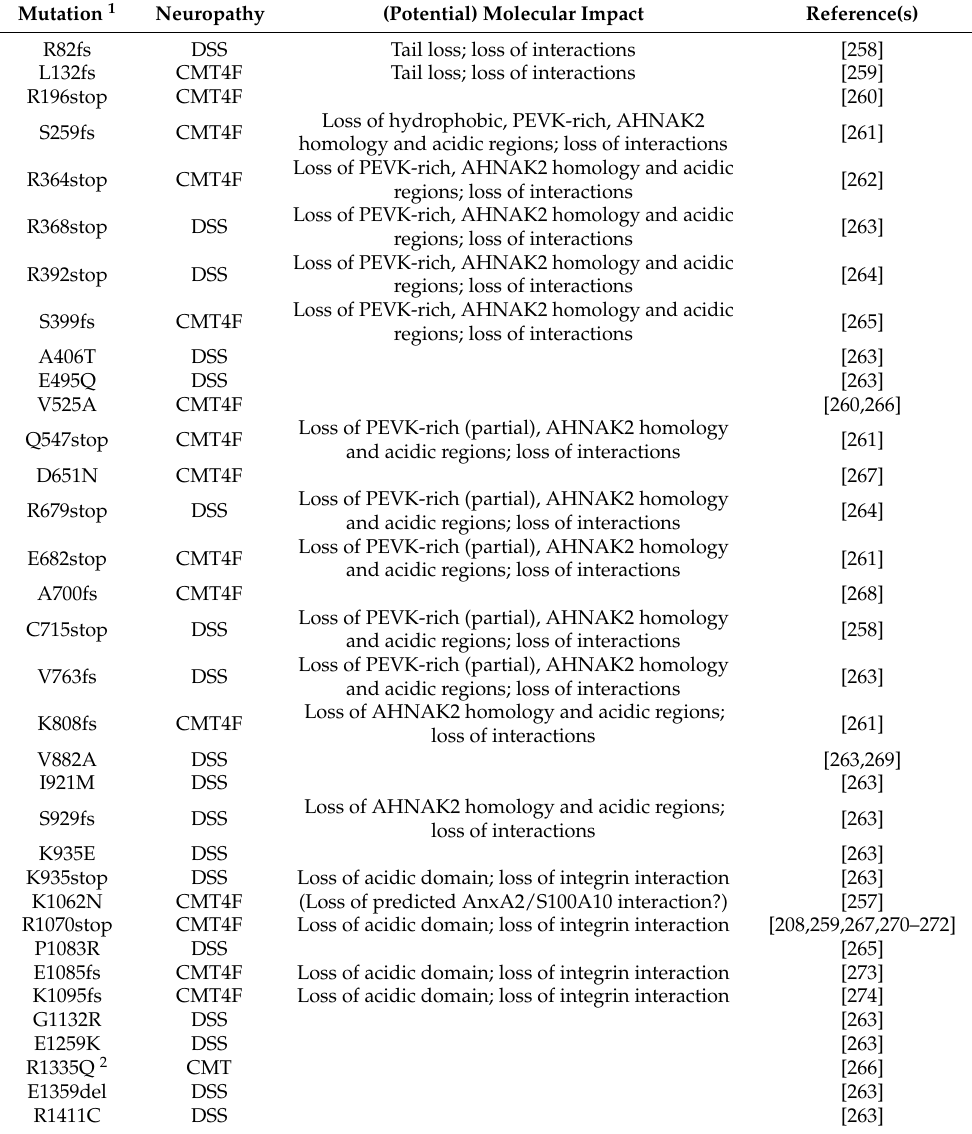
Table 1 has been modified. The updated table is shown below. Table 1. PRX mutations, related neuropathies and potential molecular